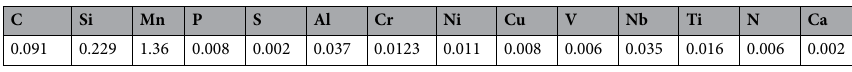
Table 1. Chemical composition of the microalloyed low carbon